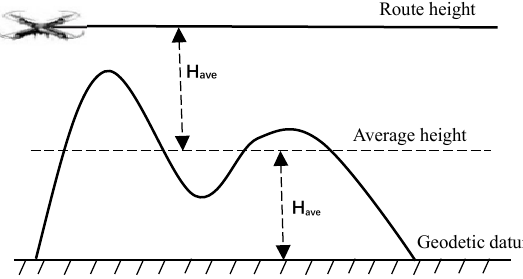
Figure 3 Schematic diagram of the average height of the relief